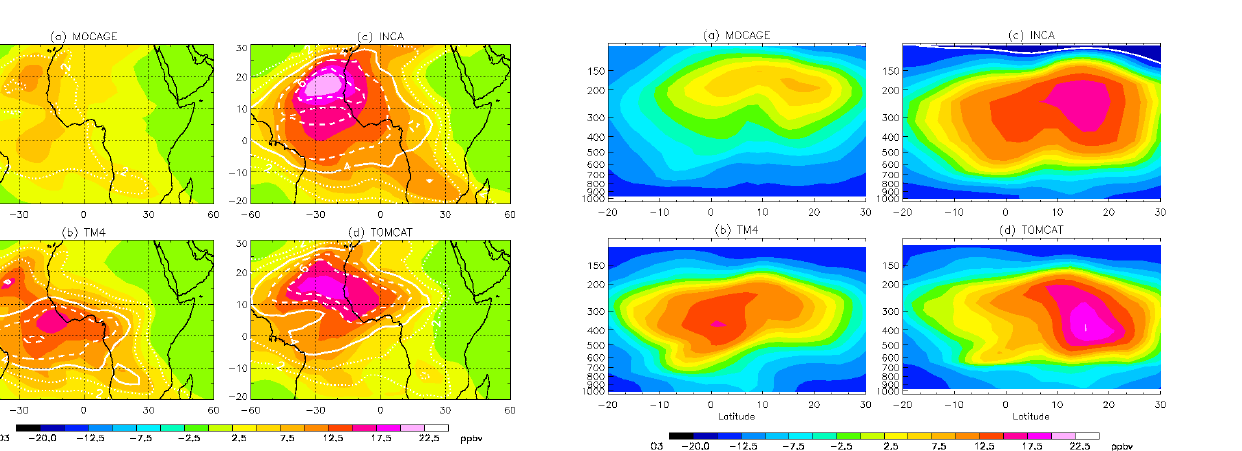
Fig. 15. August 2006 latitude-pressure cross-sections averaged over 45 ◦ W–0 ◦ E of O 3 difference between Baseline and LiNO x -off sim- ulations by (a) MOCAGE (b) TM4 (c) INCA and (d)